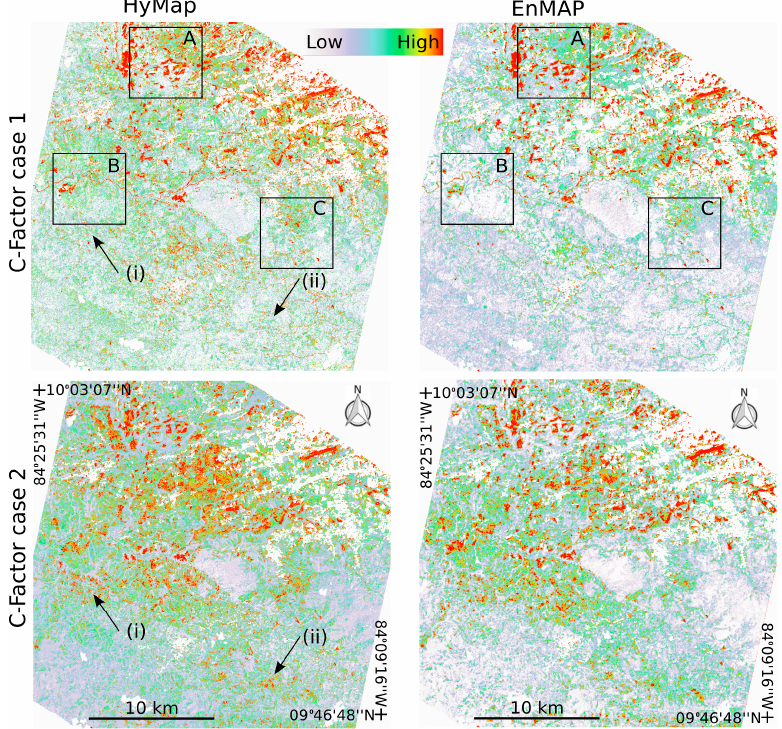
Figure 9. C-factor case 1 and 2 results for the full study area derived for HyMap and EnMAP. See text for details on arrow descriptions. Boxes 1, 2 and 3 represent zoom windows a, b and c in Figure